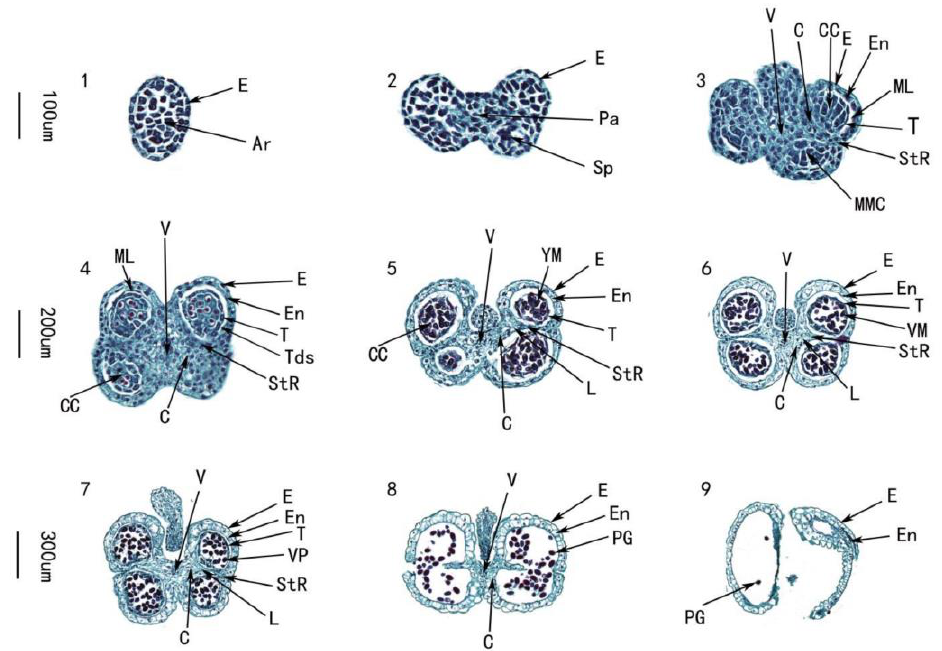
Figure 1. Transverse sections of fixed celery anthers stained with safranin O-fast green reagent at developmental stages 1–9. Pa, Parietal Tissue; Sp, Sporogenous Tissue; E, Epidermis; En, Endothecium;